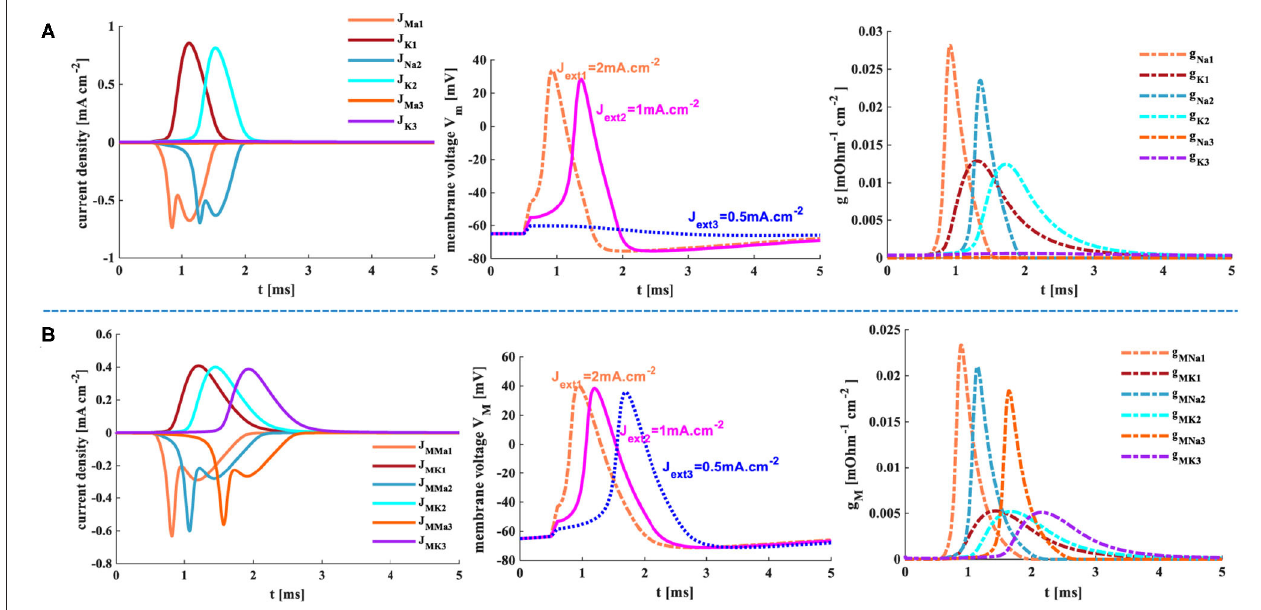
FIGURE 12 | The three different current pulses are applied to the HH and MHH spiking models. (A) The HH spiking model. (B) The MHH spiking